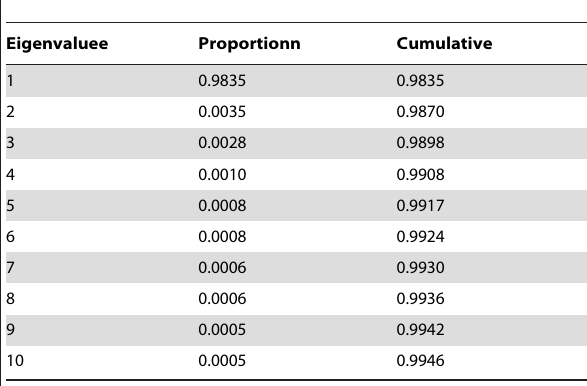
Table 4. Proportional and cumulative variance expressed by the first 10 PCs, for microarray data extracted from chip U133B.